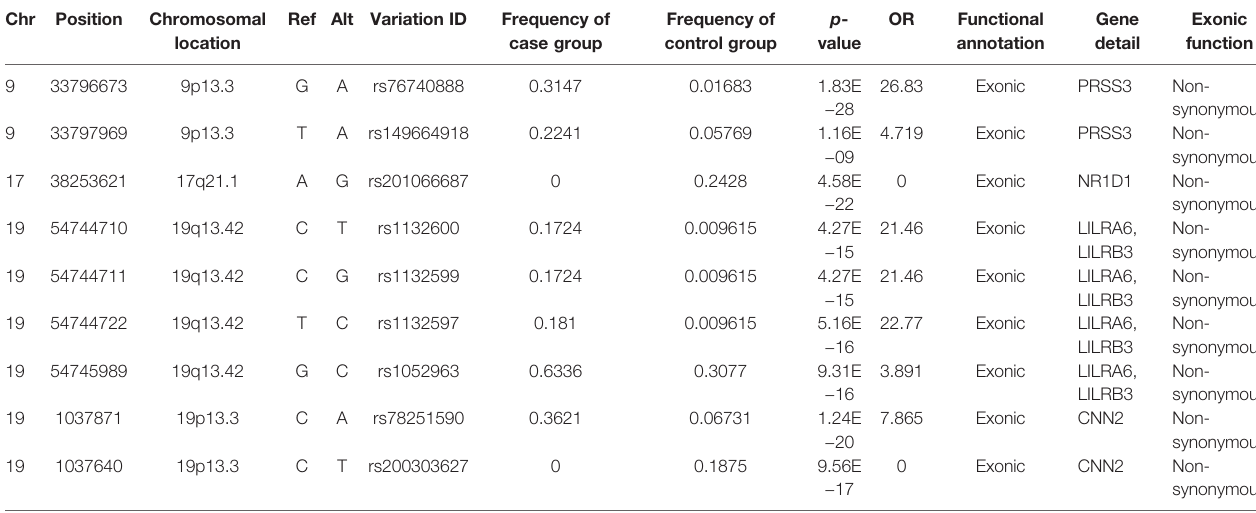
TABLE 2 | Immune-associated non-synonymous variation details in the Fisher ’ s exact test. Chr